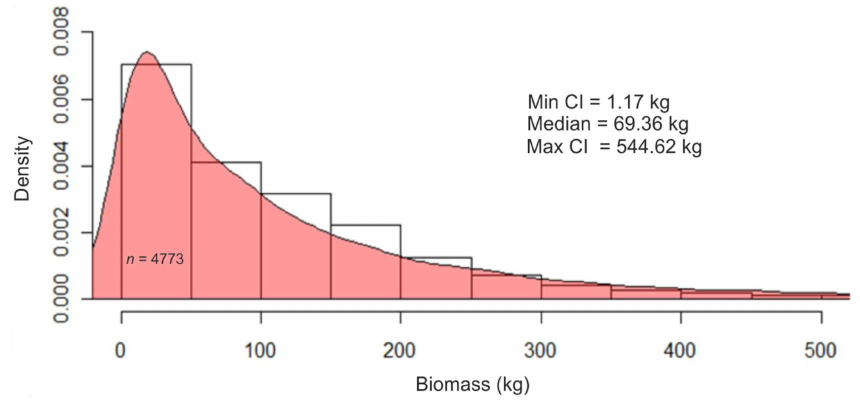
Figure 5. Weibull distribution fitted to the biomass values of P. euphratica within the monitoring